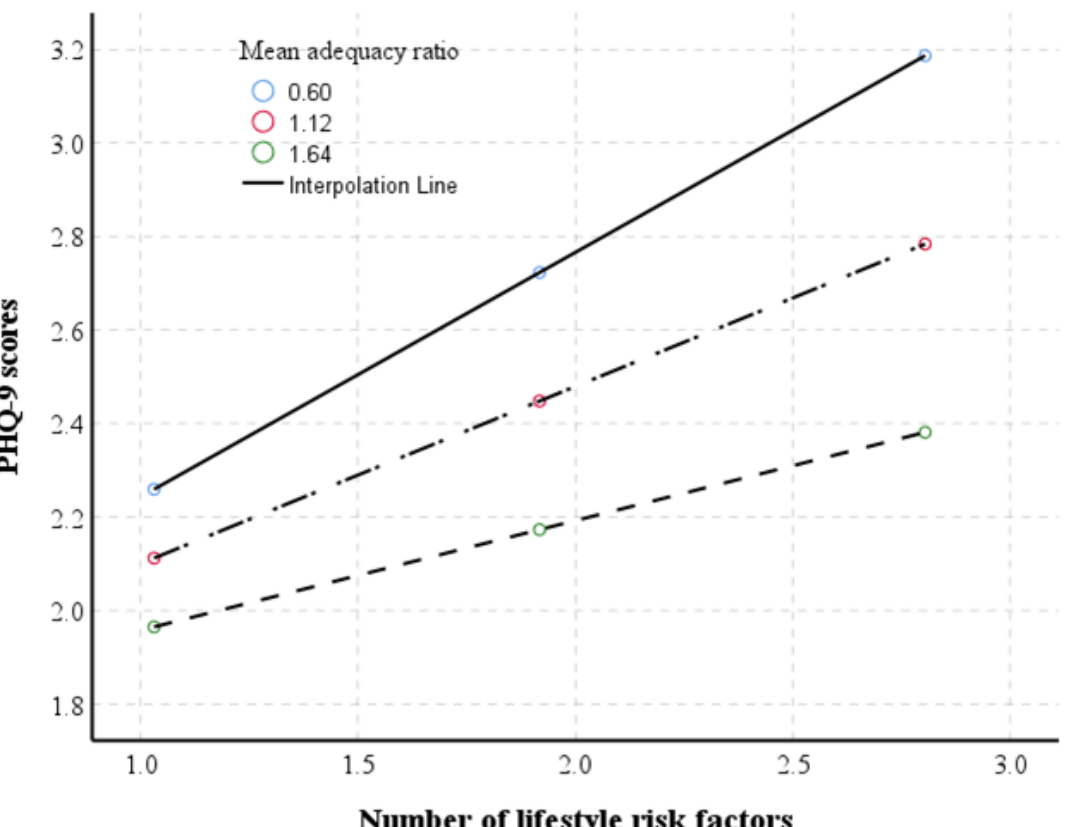
Figure 2. Illustration of the moderating effect of mean adequacy ratio on the relationship between lifestyle risk factors and patient health questionnaire (PHQ)-9